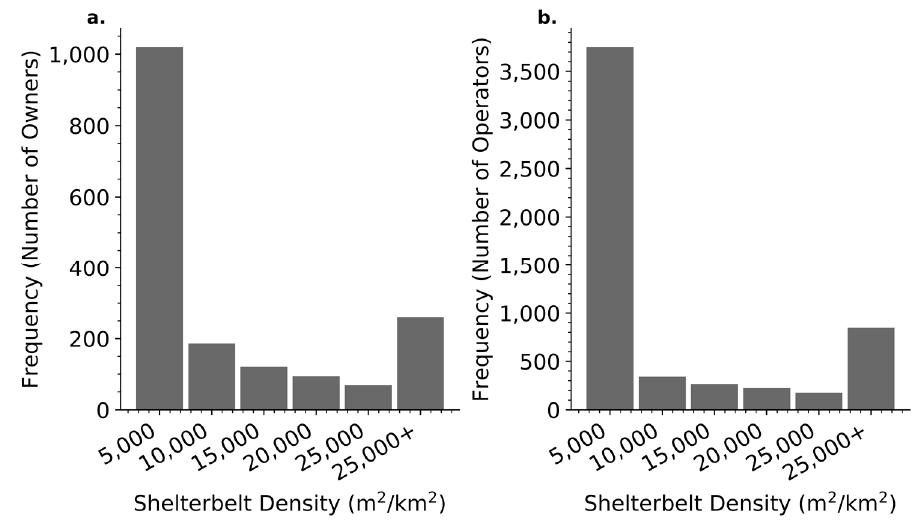
Figure 8. Distribution of total shelterbelt density in GFC owned by ( a ) all landowners or ( b ) farm operators in 2014.